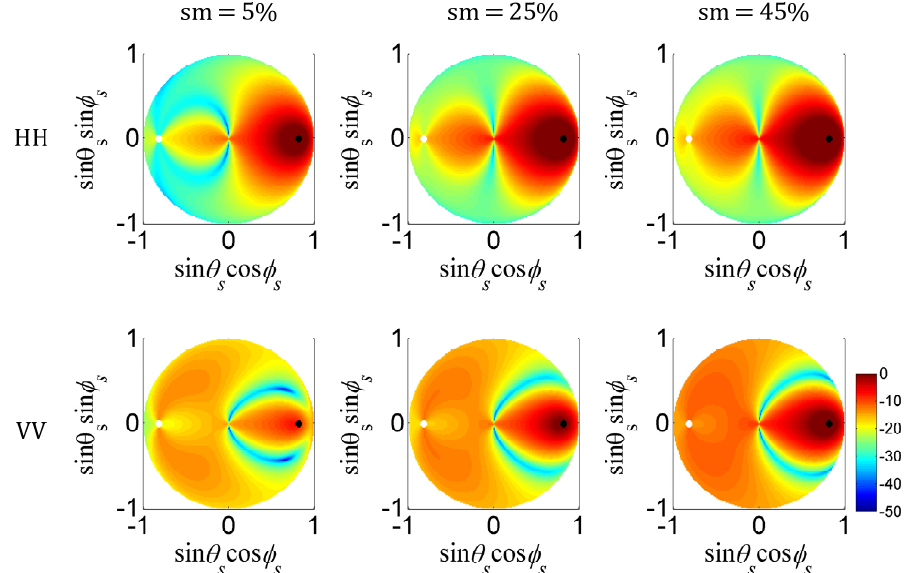
Figure 2. Patterns of bistatic scattering coefficients for changing the soil moisture (5%, 25%, and 45%) for relatively smooth ( 𝑠 = λ/10) surface.